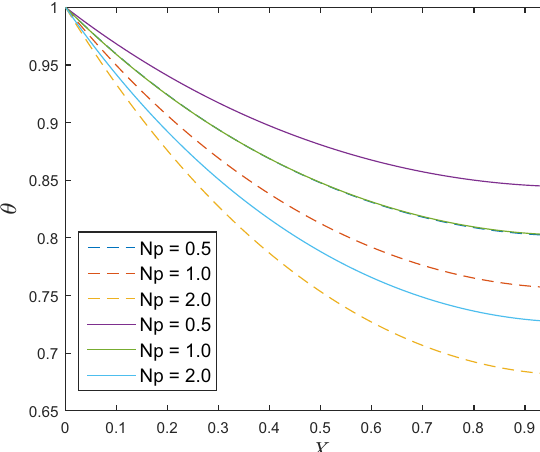
Figure 3: E ff ect of M (- - linear variation and — non - linear variation ) on the Temperature distribution of the fi n.